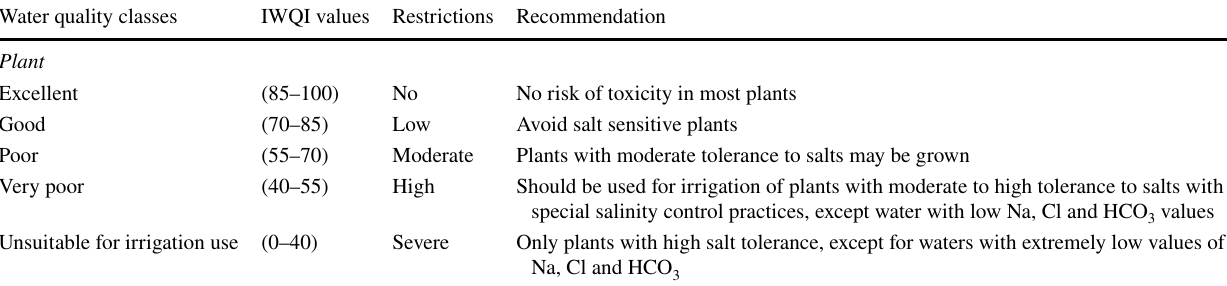
Table 5 Classification of irrigation water quality index